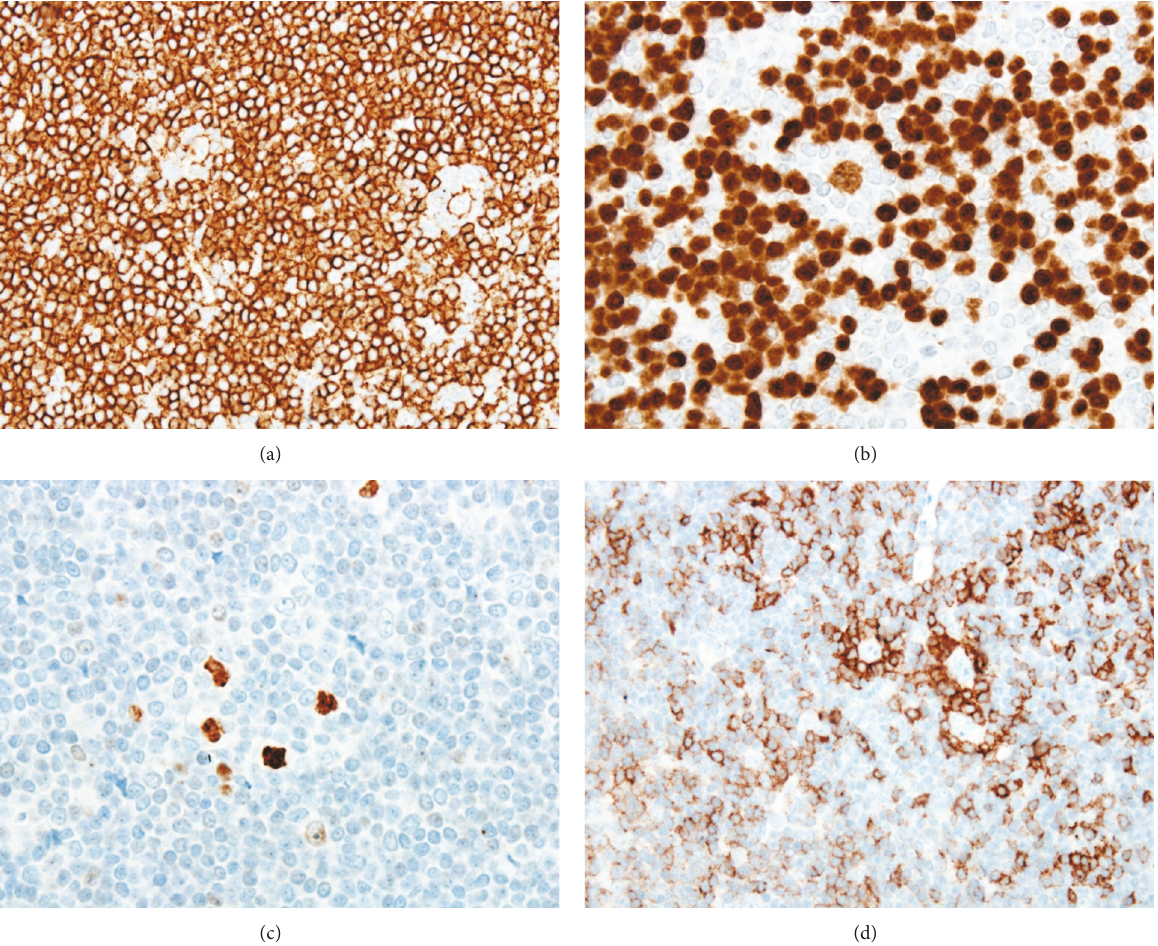
Figure 4: Immunohistochemical features of the neoplastic cells. (a) High-power image of a CD20 immunohistochemical stain shows expression by the scattered large neoplastic cells. Numerous small B-cells in the background also are positive. (b) A PAX5 stain also shows positivity in the large neoplastic cells and small background B-cells. (c) An OCT2 stain shows strong nuclear staining in the neoplastic